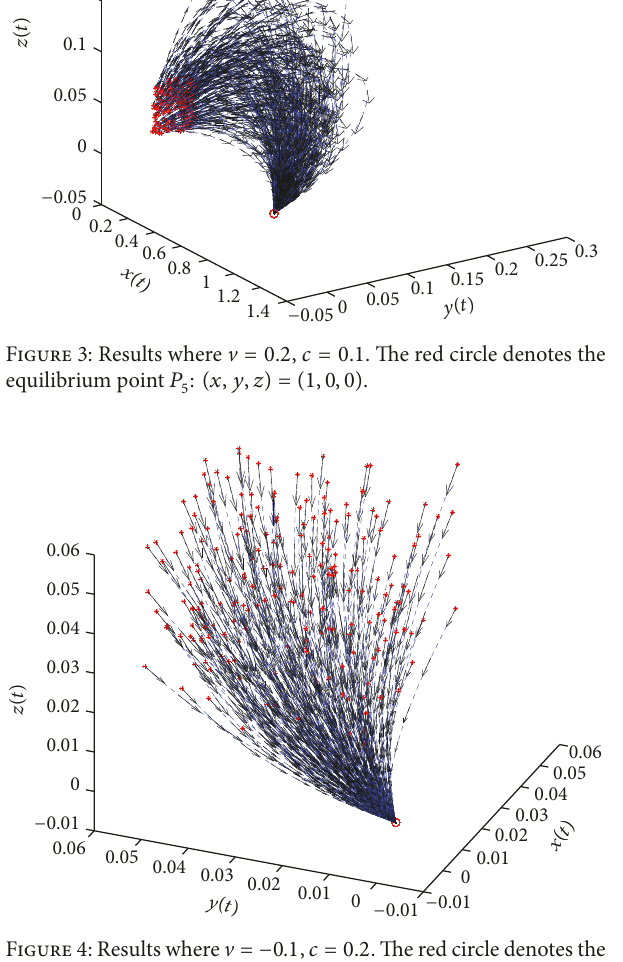
Figure 4: Results where V = −0.1 , 𝑐 = 0.2 . The red circle denotes the equilibrium point 𝑃 7 : (𝑥,𝑦,𝑧) = (0,0,0) .